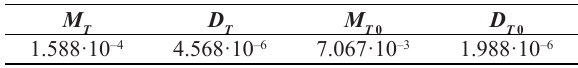
Table 2. Mathematical expectation and variance of the mean- square deviation over the flowmeter ball rotation period.